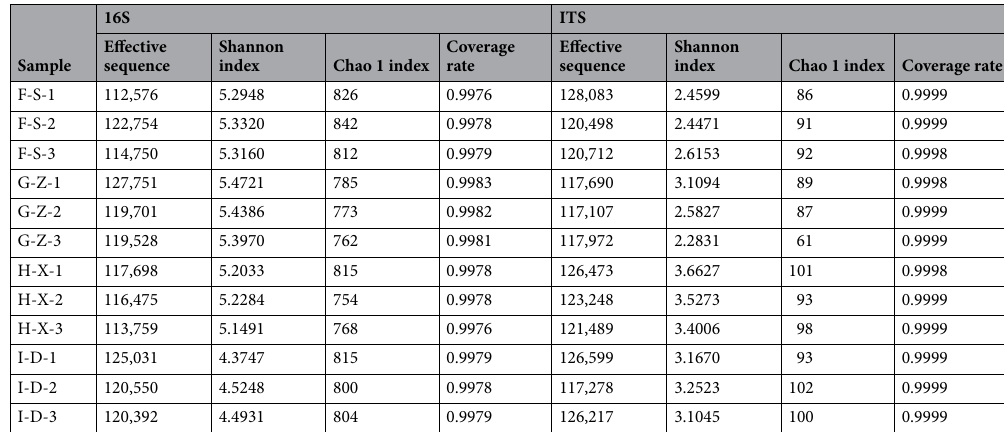
Table 1. Basic sequencing data obtained from pit mud from F-S, G-Z, H-X and I-D. F-S, upper layer; G-Z, middle layer; H-X, lower layer; I-D, bottom